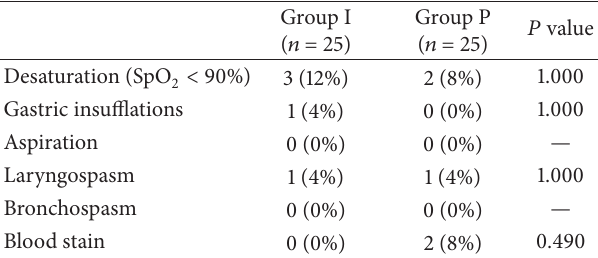
Table 3: Complications during surgery and emergence. Values are number